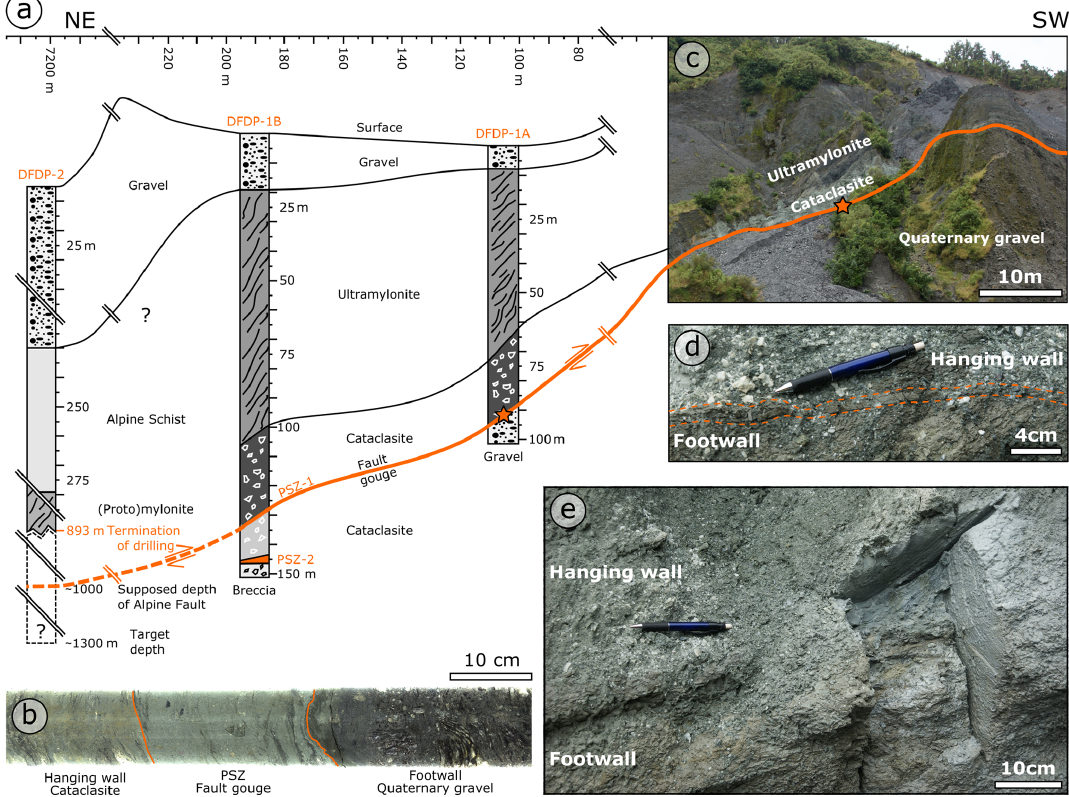
Figure 3. (a) Schematic overview of Deep Fault Drilling Project (DFDP) boreholes drilled in phase 1 at Gaunt Creek and phase 2 within the Whataroa River valley. Star at DFDP-1A indicates location of (b) . (b) Segment of 180 ◦ scan of PSZ encountered at DFDP-1A drill core (run 66, section 1). (c) Individual fault rock units of the Alpine Fault Zone are well-recognizable at the outcrop Gaunt Creek, in close proximity to the DFDP boreholes. Star indicates location of (d) and (e) . (d) An approximately 1cm thick, brown layer indicated by stippled orange lines, was interpreted to represent the PSZ at Gaunt Creek. (e) Sample location (specimen shown in Fig. 5b) some 10s of centimeter SW of location shown in (d) . Figure modified according to Sutherland et al. (2012) and Boulton et al.